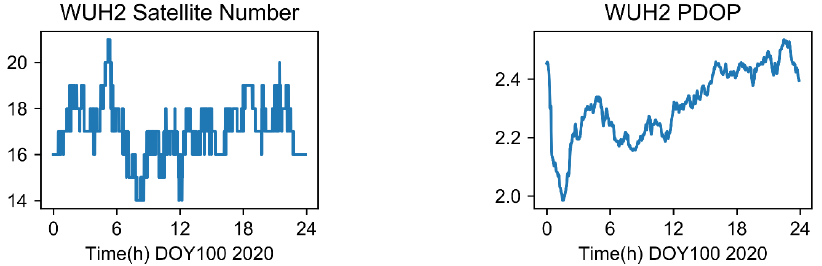
Figure 4. The visible satellite number and PDOP value of the WHU2 station and BDS satellite.